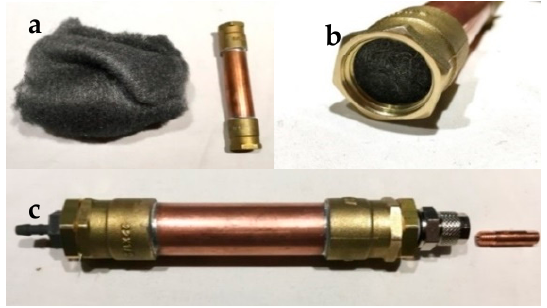
Figure A4. Flame-breaker assembly.